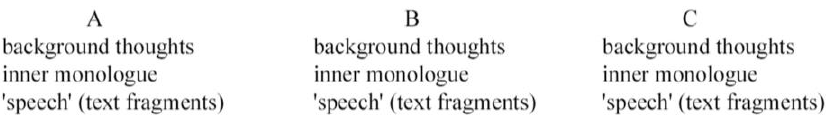
Figure 1. Compositional Planes.